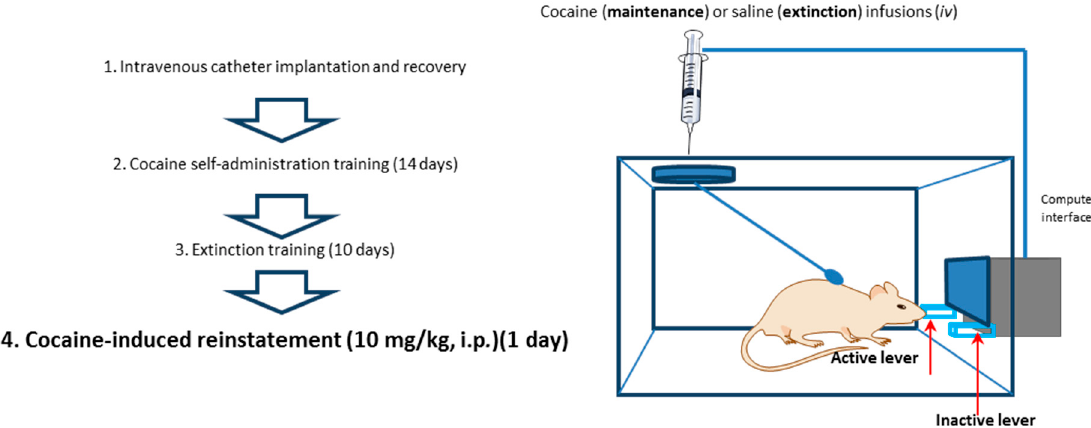
Figure 7. Illustration of cocaine self-administration experiments.